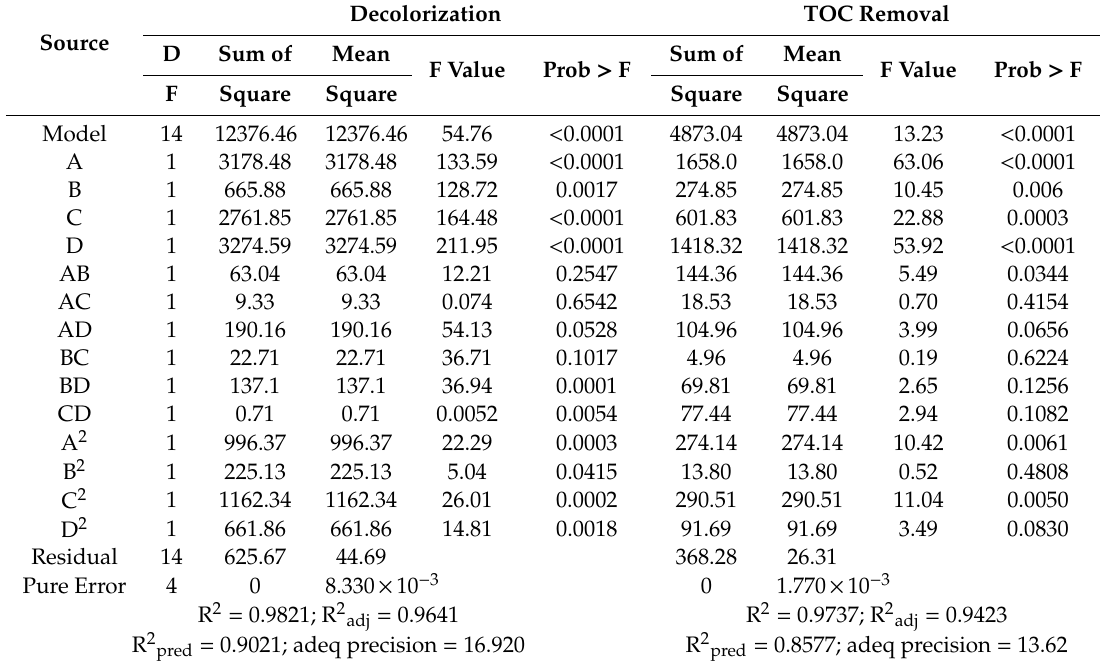
Table 2. ANOVA results of the quadratic models for MB